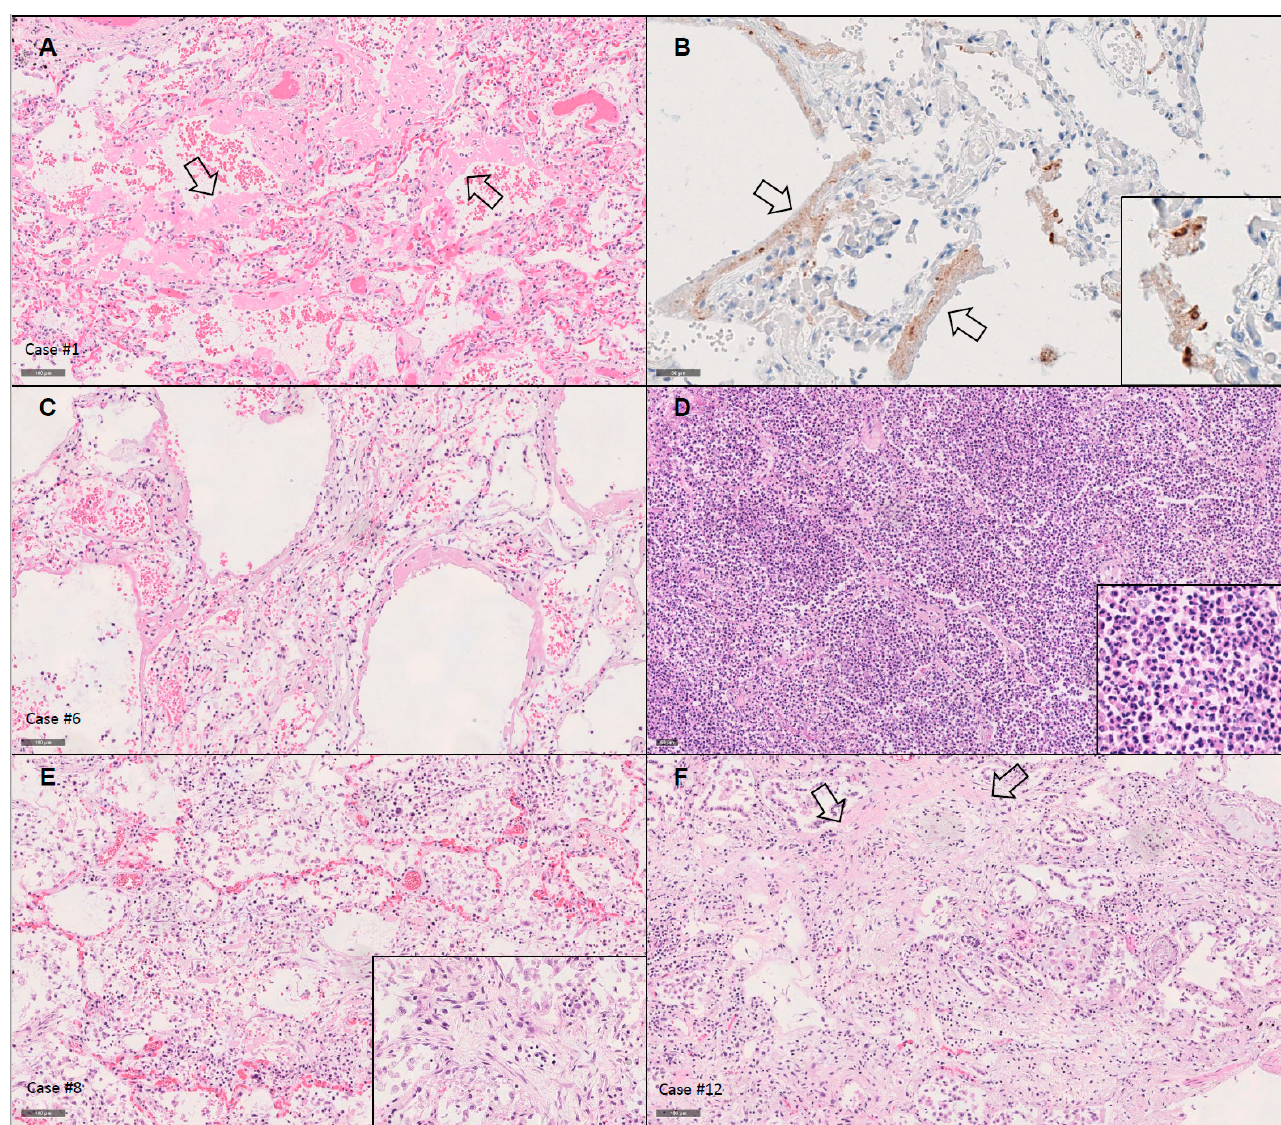
Figure 1. Lungs showed diffuse alveolar damage in different stages of evolution. ( A ) Acute exudative phase with extensive hyaline membranes formation (arrows), without thickening of alveolar septa (case #1; H&E, ×100). ( B ) In the patients with exudative phase diffuse alveolar damage, SARS-CoV-2 antigen was present in the hyaline membranes (arrows) and scattered cells (inset), as exemplified in case #1 using the nucleocapsid protein antibody (×200). ( C ) In the late exudative phase some septal thickening and focal early organization was present apart from extensive hyaline membrane formation (case #6; H&E, ×100). ( D ) Half of our cohort had superimposed (bacterial) acute bronchopneumonia, as exemplified in case #6 (H&E, ×100; inset with higher magnification, highlighting densely packed granulocytes). ( E ) Proliferative phase presented with fibrosis, obliterating alveolar lumina, as highlighted in the inset (case #8; H&E, ×100). ( F ) The density and collagen richness of fibrosis (arrows) increased with longer-standing disease, as exemplified in case #12 (H&E, ×100).